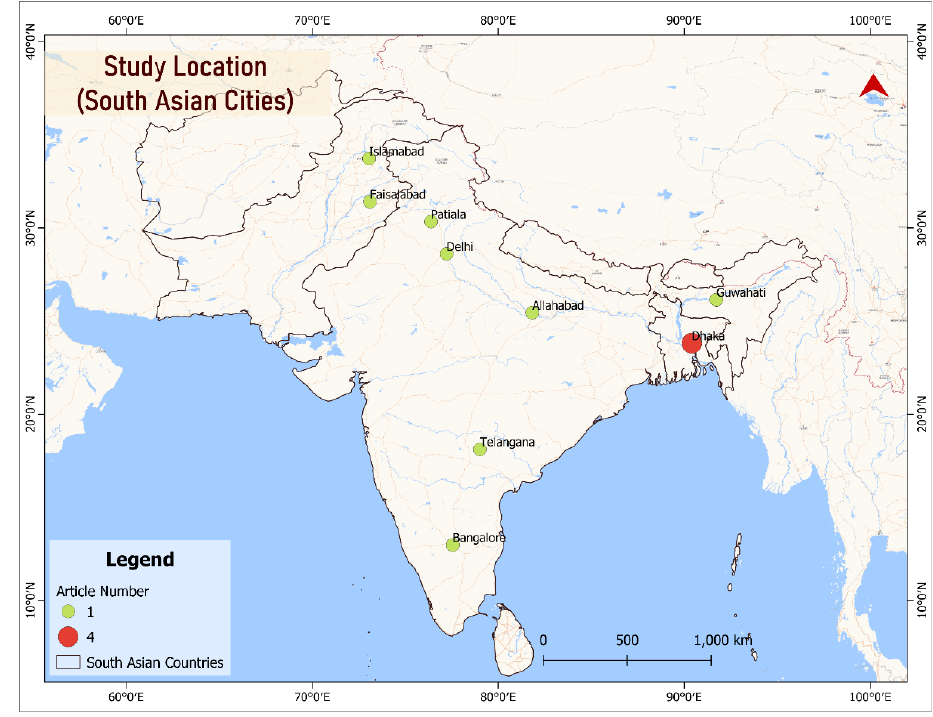
Figure 2. Study location with number of articles.